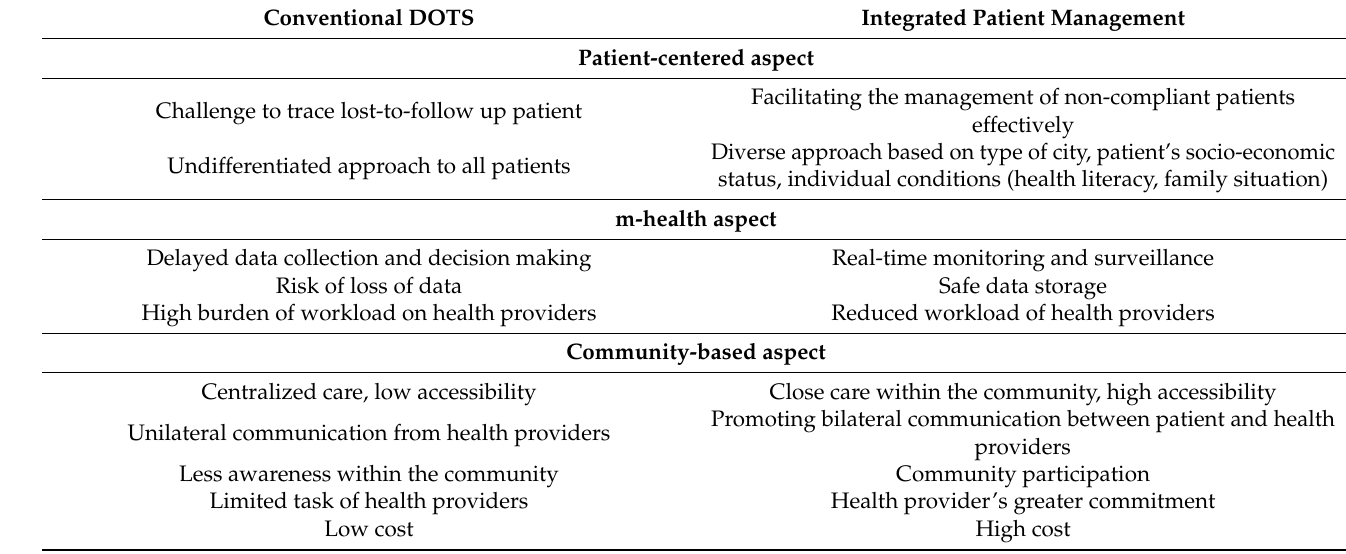
Table 3. Comparison of conventional DOTS and integrated patient